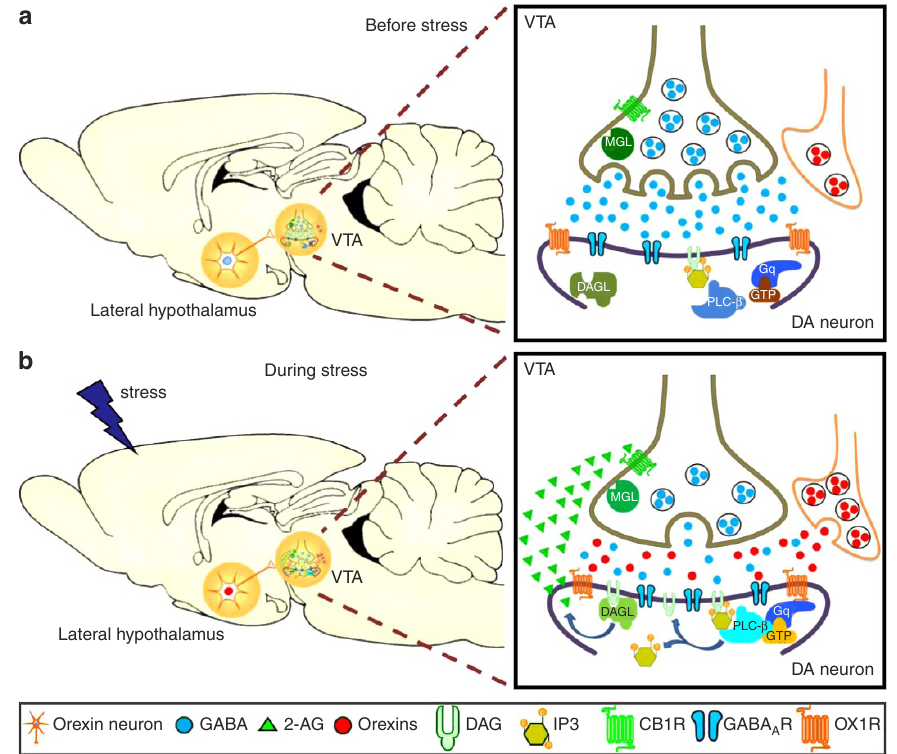
Figure 8 | A schematic illustration of how stress-released orexins induce an endocannabinoid-mediated relapse for cocaine-seeking. This scheme was illustrated by using the Biology Bundle of Motifolio PPT Drawing Toolkits (Motifolio Inc, MD) to describe what may occur in the LH and the VTA ( a ) before stress and ( b ) during stress. Right boxes are enlarged portions of synaptic events occurring in a GABAergic synapse onto a dopaminergic neuron in the VTA. During stress, LH orexin neurons are activated and release orexins. The released orexins then activate postsynaptic OX1 receptors on dopaminergic neurons in the VTA. Activation of the OX1 receptor, a G q -protein coupled receptor, leads to PLC activation, generating DAG that is converted into 2-AG, an endocannabinoid, by DAGL. 2-AG travels retrogradely across the synapse to inhibit GABA release by activating presynaptic CB1 receptors on the GABAergic terminal. Inhibition of GABAergic synaptic neurotransmission onto dopaminergic neurons in the VTA results in activation of the mesolimbic dopaminergic circuitry, leading to a reinstatement of extinguished cocaine CPP, modelling cocaine relapse in humans. Finally, 2-AG is degraded by MAGL, which is located in GABAergic terminals. Thus, the MAGL inhibitor potentiates and prolongs orexin A-induced IPSC